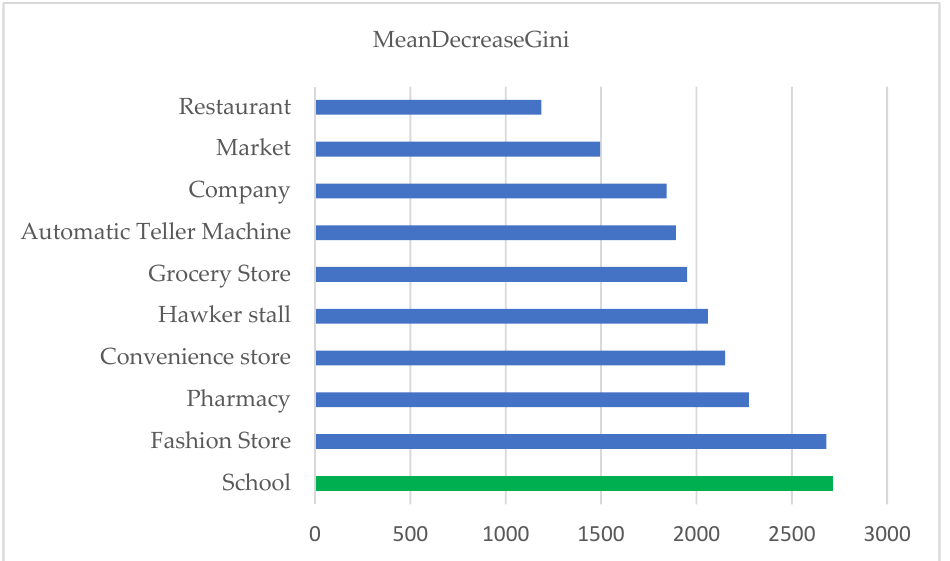
Figure 11. A study on the estimation land value using points-of-interest data and the machine learning classification algorithms for the Talingchan district, Bangkok.